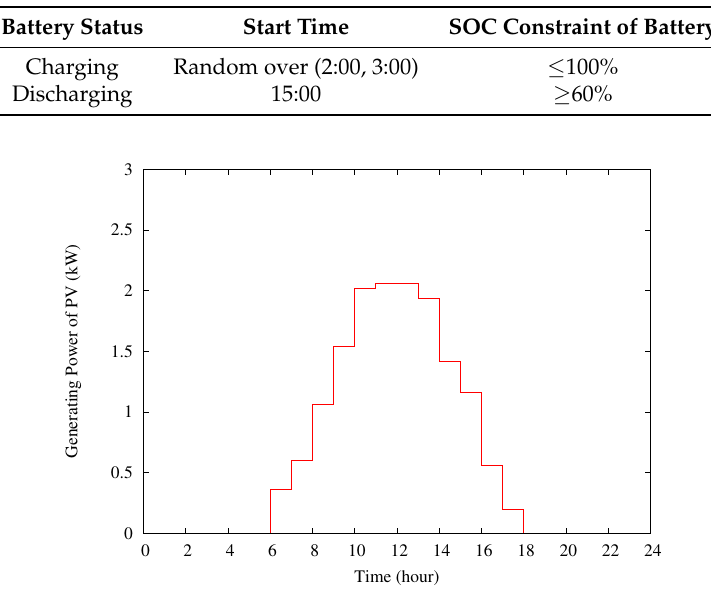
Figure 11. Generating power of 12 solar panels